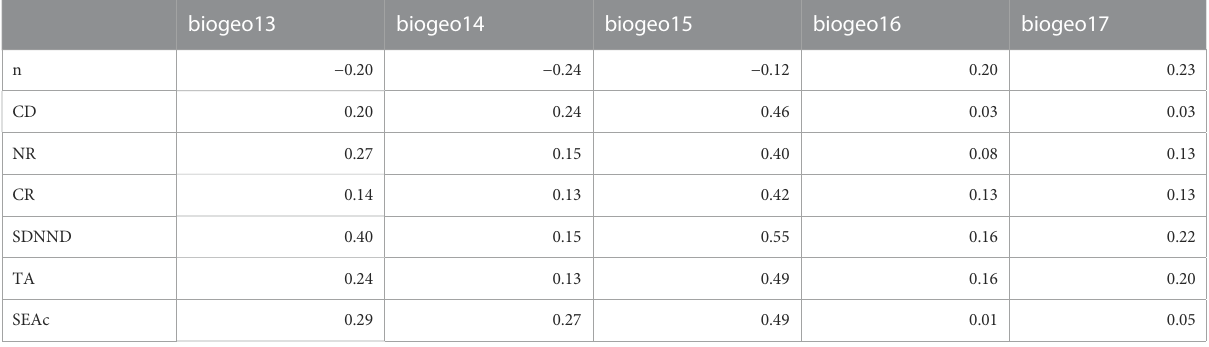
TABLE6Correlationmatrix(Pearsonrcoef fi cient)betweenMARSPECtemperature-relatedpredictors(seeTable1foracronyms)andsamplenumber(n),mean distance to centroid (CD), nitrogen range (NR), carbon range (CR), standard deviation of nearest neighbor distance (SDNND), total area (TA), and corrected standardellipsearea(SEAc)ofthe12 Callinectessapidus populationsincludedintheindividual-scaledataset.Allmetricslog-transformedandmean-centered before